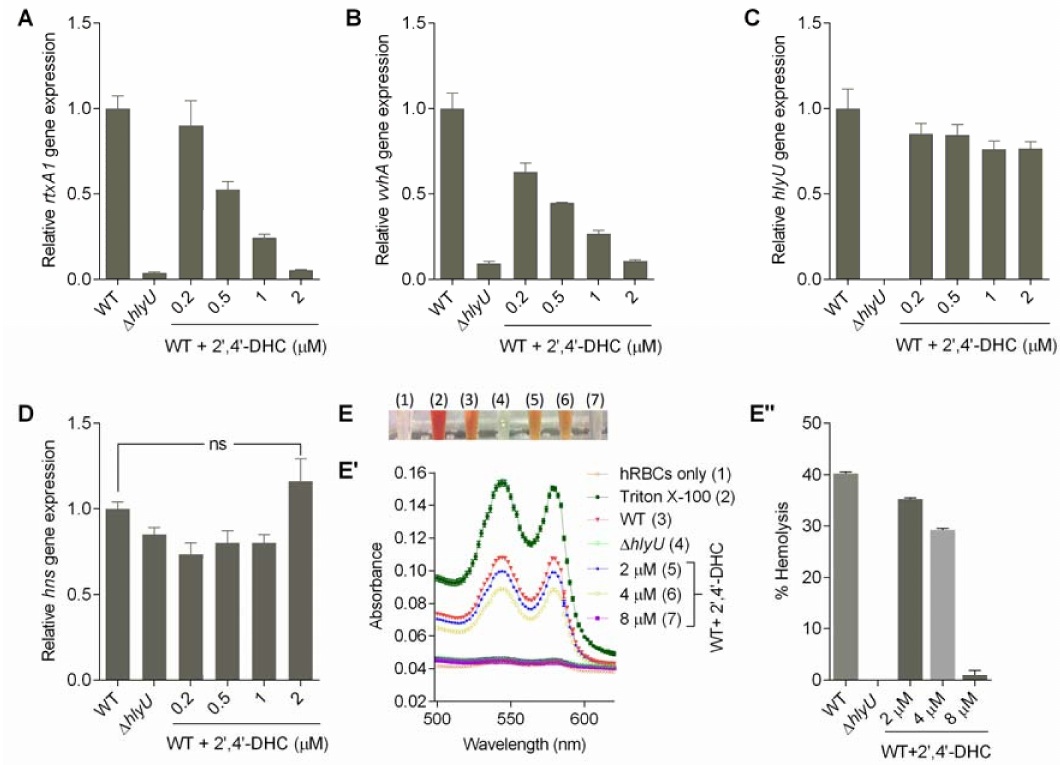
Figure 3. Effect of 2 (cid:48) ,4 (cid:48) -DHC on the expression of HlyU-regulated genes and on the virulence phenotype of V. vulnificus . ( A , B ) Effect of 2 (cid:48) ,4 (cid:48) -DHC treatment on gene expression of HlyU-regulated toxins ( rtxA1 and vvhA ) and ( C , D ) global regulators ( hlyU , hns ) in the WT V. vulnificus. The expression of the target genes in the ∆ hlyU strain was also monitored as a negative control. The target gene expression was normalized with the endogenous control gene (gyrB). The relative expression level of target gene against untreated WT sample is displayed; ( E ) inhibitory effect of 2 (cid:48) ,4 (cid:48) -DHC treatment on the hemolysis activity of V. vulnificus . Inhibitory effect of 2 (cid:48) ,4 (cid:48) -DHC on the hemolysis activity is visualized by the color of lysed hRBCs in e-tubes. The number in brackets represent the hemolysis conditions mentioned in E’; (E’) qualitative analysis of hemolysis inhibition shown by absorption spectra (500 to 650 nm) of chemical treated and untreated hRBCs; and ( E ”) inhibitory effect of 2 (cid:48) ,4 (cid:48) -DHC on the hemolysis activity is quantified by percent hemolysis that is expressed as 100 × (A 540 of hRBCs treated with inhibitor/A 540 of hRBCs treated with 1% Triton X-100). 2.5. Mechanism of Action of 2 (cid:48) ,4 (cid:48) -DHC and Its In Vivo